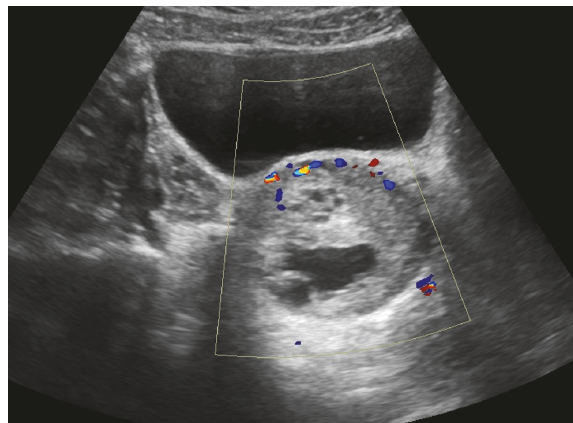
Figure 1: Ultrasound image of ovarian lesion.